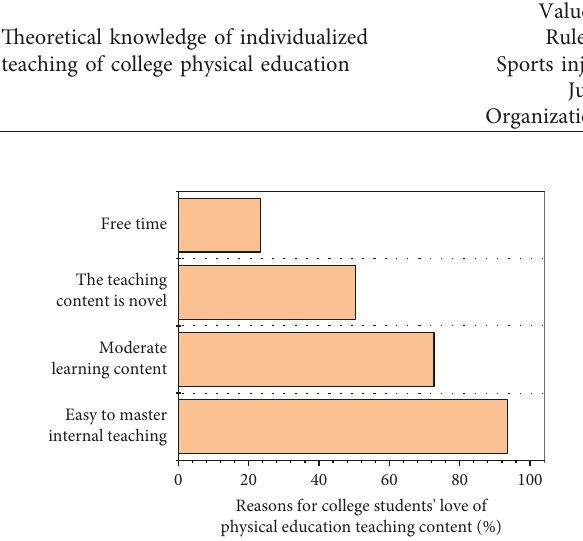
Figure 1: Reasons for college students’ liking of physical education teaching Table 7: Pilot the evaluation method of PE courses in colleges and universities ( n � 15).